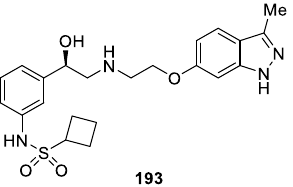
Figure 65. Chemical structures of 1 H -indazole derivatives 191 and 192 .